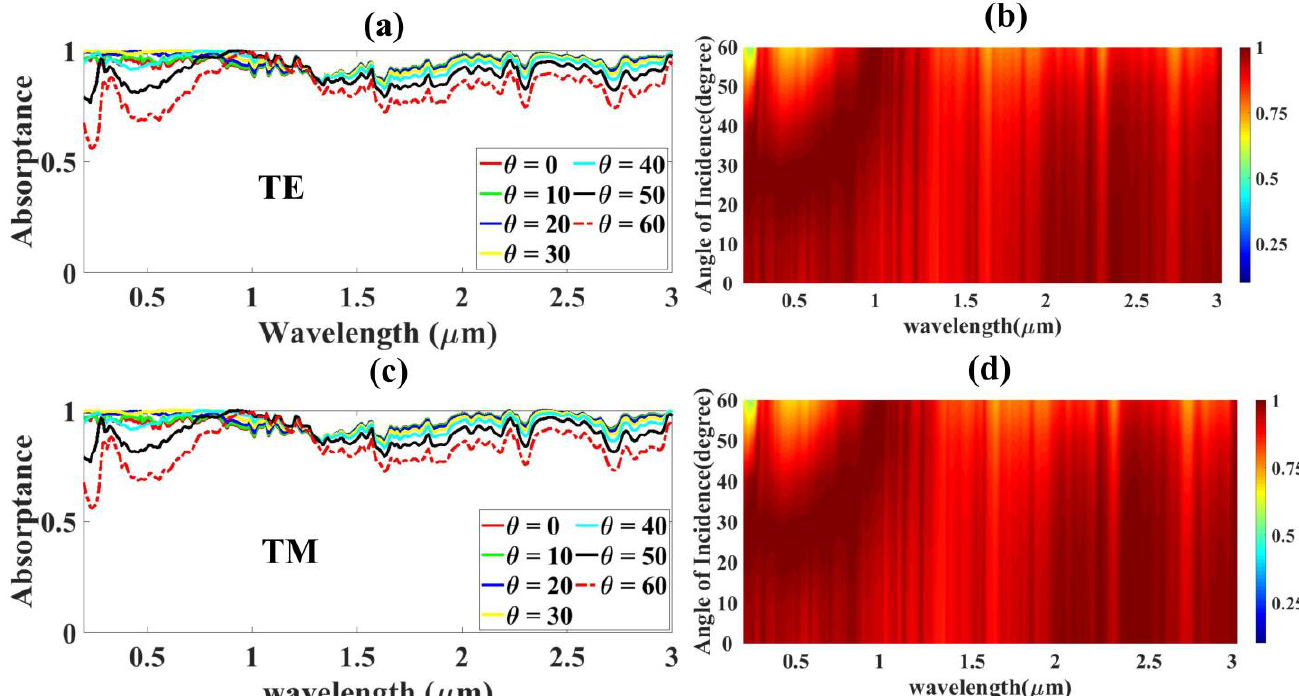
Figure 7. Concentric GST ring solar absorber’s absorption rates ( a ) the absorption rate changes of concentric GST ring solar absorber between 0 and 60 degrees in TE mode, ( b ) the absorption rate changes of concentric GST ring solar absorber between 0 and 60 degrees in TE mode demonstrated by the fermi plot, ( c ) the absorption rate changes of concentric GST ring solar absorber between 0 and 60 degrees in TM mode, ( d ) the absorption rate changes of concentric GST ring solar absorber between 0 and 60 degrees in TM mode demonstrated by the fermi plot.